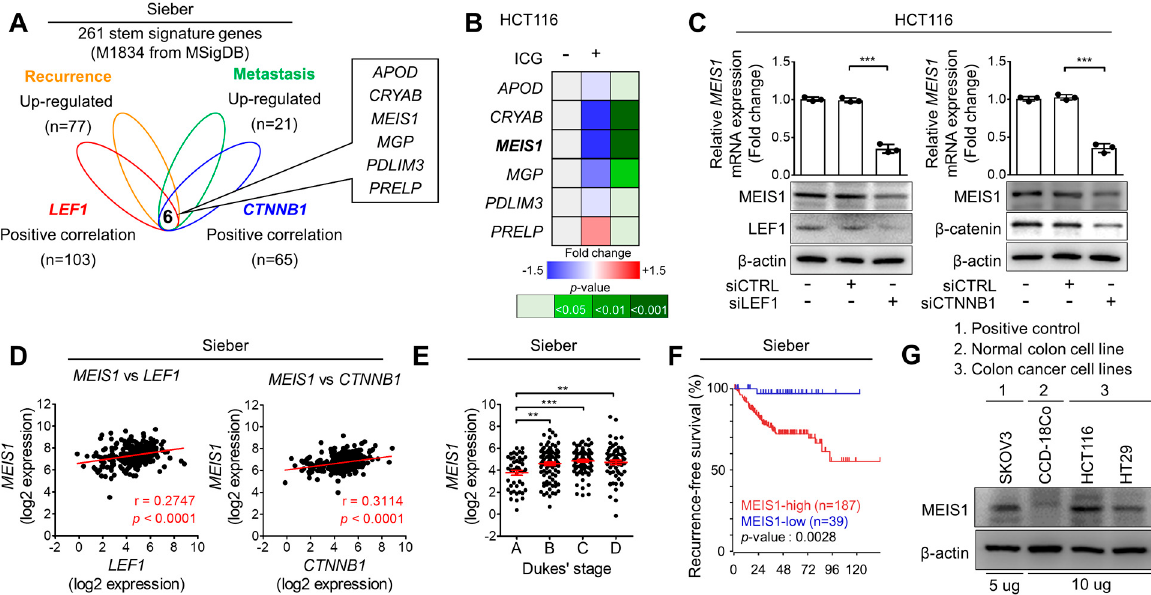
Figure 3. Identification and validation of MEIS1 as a potential target gene of ICG − 001. ( A ) Identification of candidate target genes of ICG − 001. Stemness signature genes were filtered by overlapping four gene sets obtained from the transcriptomic data of tumors from CRC patients. Six candidate genes were upregulated in both recurrent and metastatic tumors and positively correlated with LEF1 and β -catenin (CTNNB1) expression. ( B ) RT − qPCR validation performed after ICG − 001 treatment (2.5 µ M, 72 h). The data are presented as a heatmap with fold changes and p − values. ( C ) RT − qPCR and Western blot analyses conducted 48 h after LEF1 or β -catenin knockdown. ( D ) Gene expression correlations between MEIS1 and LEF1/ β -catenin. ( E ) MEIS1 transcript levels according to the degree of CRC progression (Dukes’ stage). ( F ) Kaplan–Meier survival analyses of CRC patients based on MEIS1 expression. ( G ) Western blot analyses comparing the MEIS1 protein level in multiple human cell lines. ** and *** indicate p < 0.01 and p < 0.001, respectively.